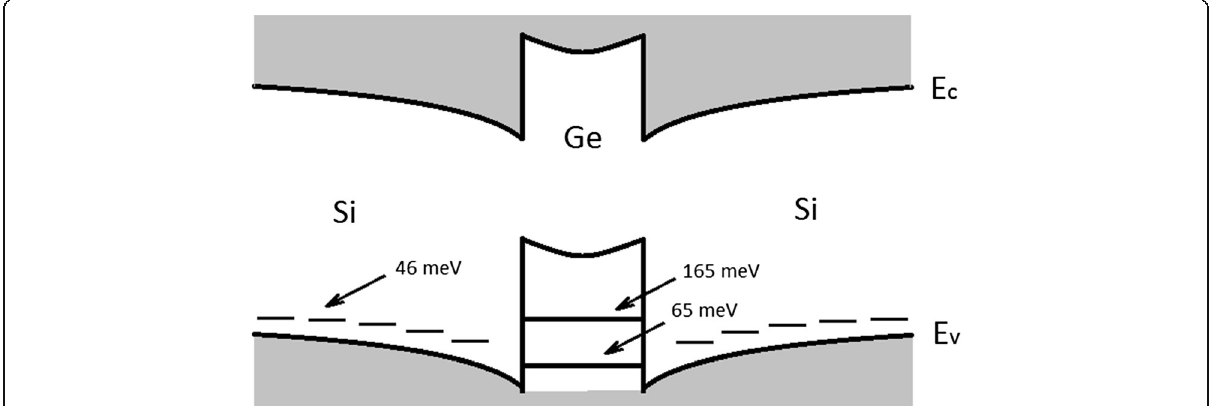
Fig. 6 Schematic image of the band structure and energy levels of Ge quantum dots in